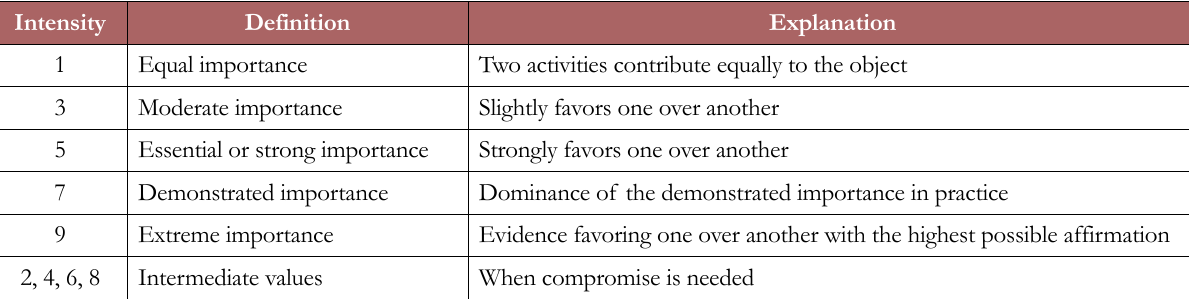
Table 2. Measurement of Criteria